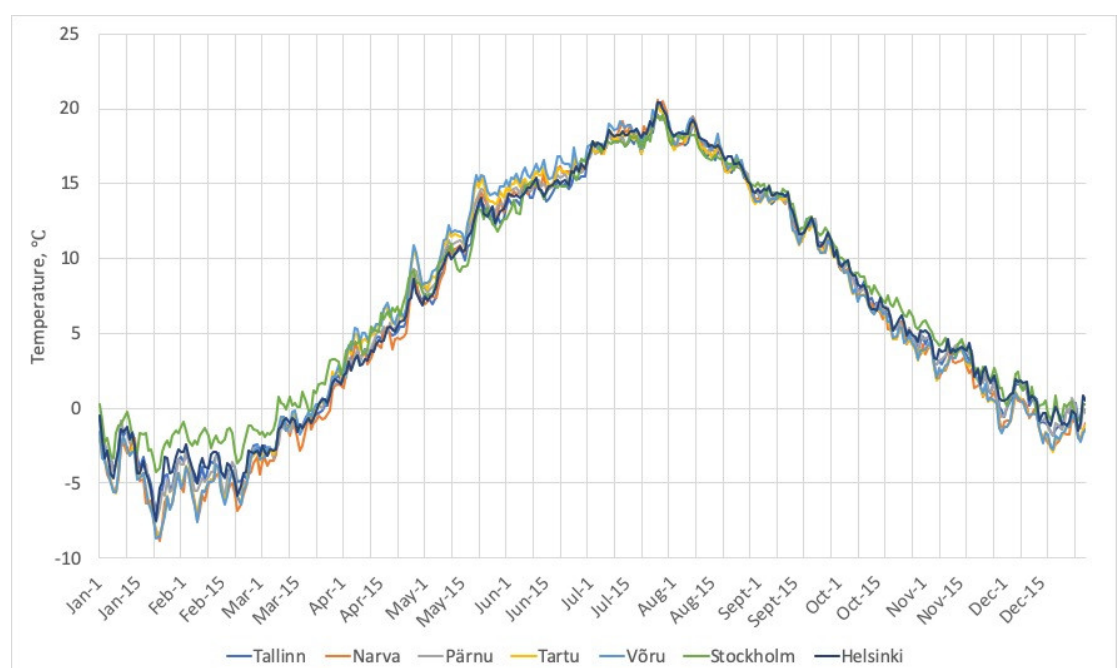
Figure 2. Annual changes in average daily temperatures as an average of the years 2005–2019.